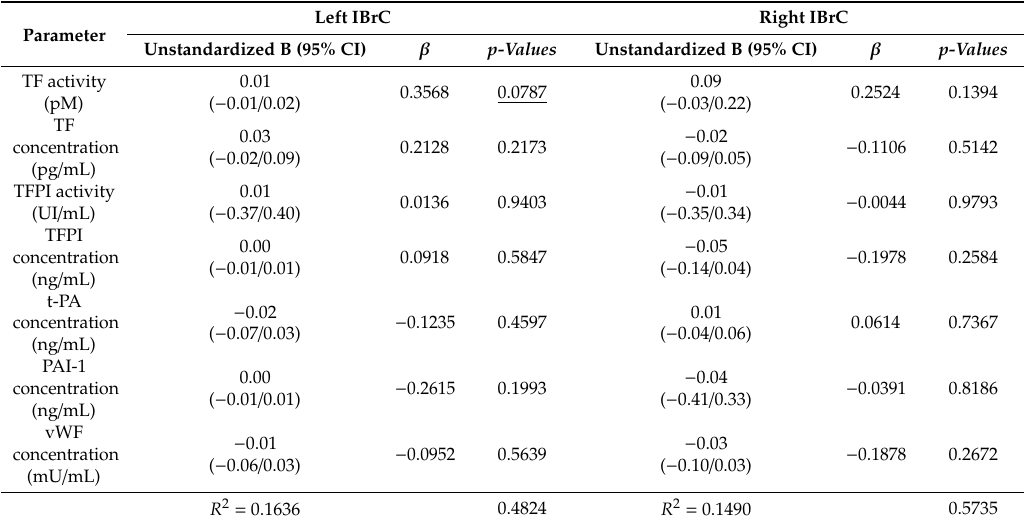
Table 8. Prognostic value of hemostatic variables with respect to tumor laterality assessed by linear